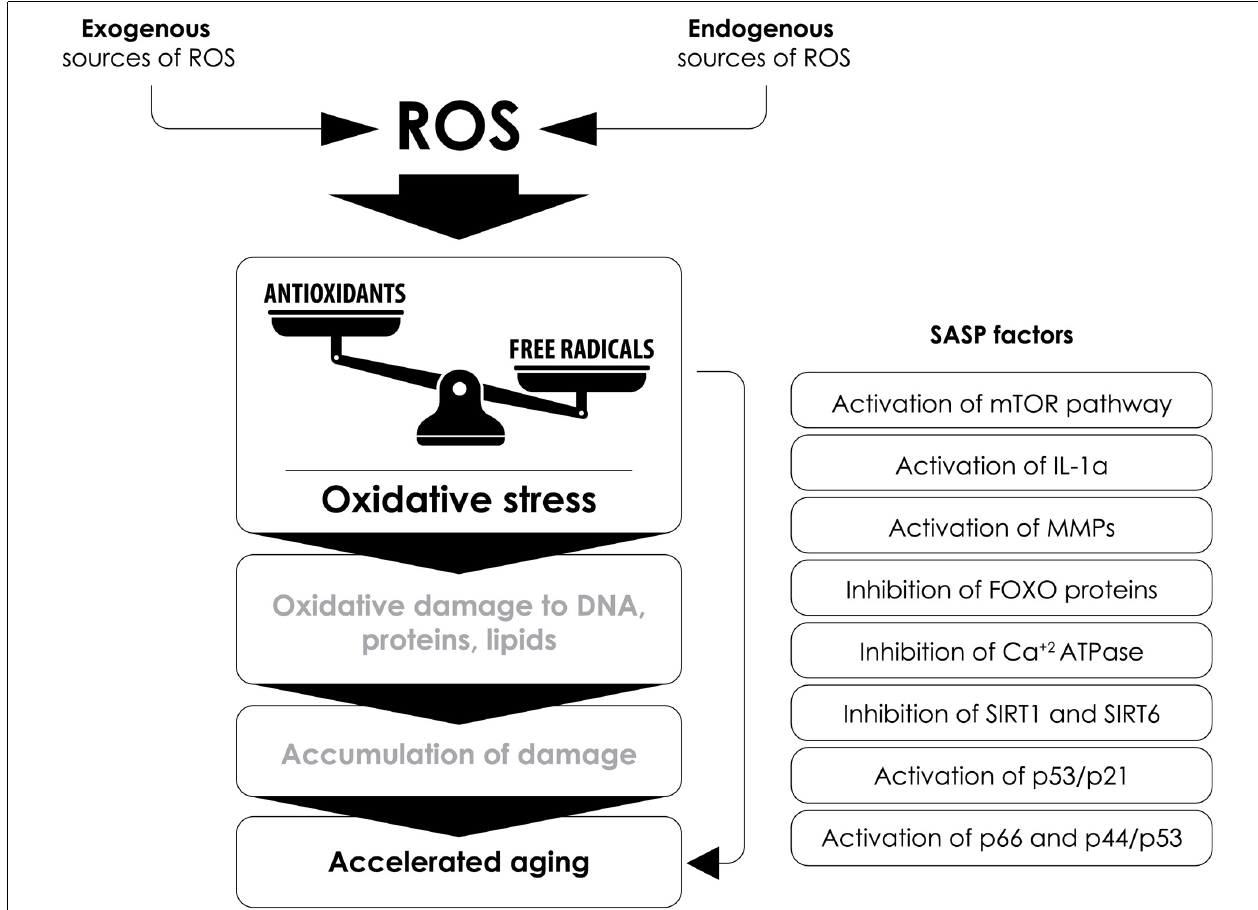
FIGURE 6 | The interplay between oxidative stress, SASP factors and accelerated aging. Several senescence-associated secretory phenotype (SASP) factors that contribute to accelerated aging are affected by the increased production of reactive oxygen species (ROS) and oxidative stress. SASP, senescence-associated secretory phenotype; mTOR, mammalian target of rapamycin; IL-1 α , interleukin-1 α ; MMPs, matrix metalloproteinases; FOXO, Forkhead box; Ca ++ -ATPase, calcium ATPase; SIRT1, sirtuin 1; SIRT6, sirtuin